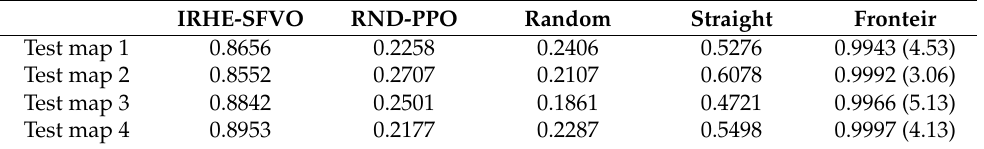
Table 4. The average exploration ratios of the proposed method and baselines on the four test maps. The brackets indicate the average number of times when the agent driven by the frontier-based strategy collides with moving obstacles in 15 spatial explorations on different test